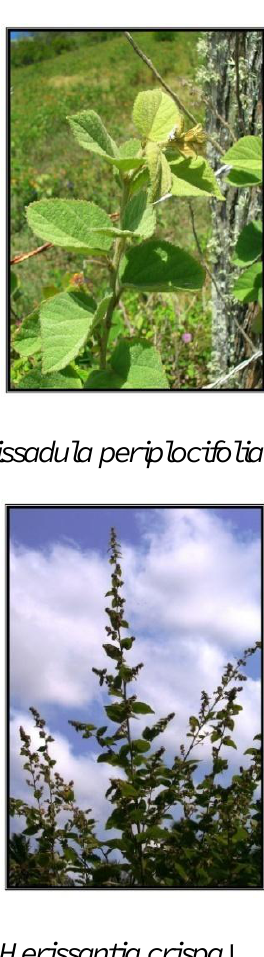
Figure 1. Sidastrum micranthum (A. St.-Hil.) Fryxell.